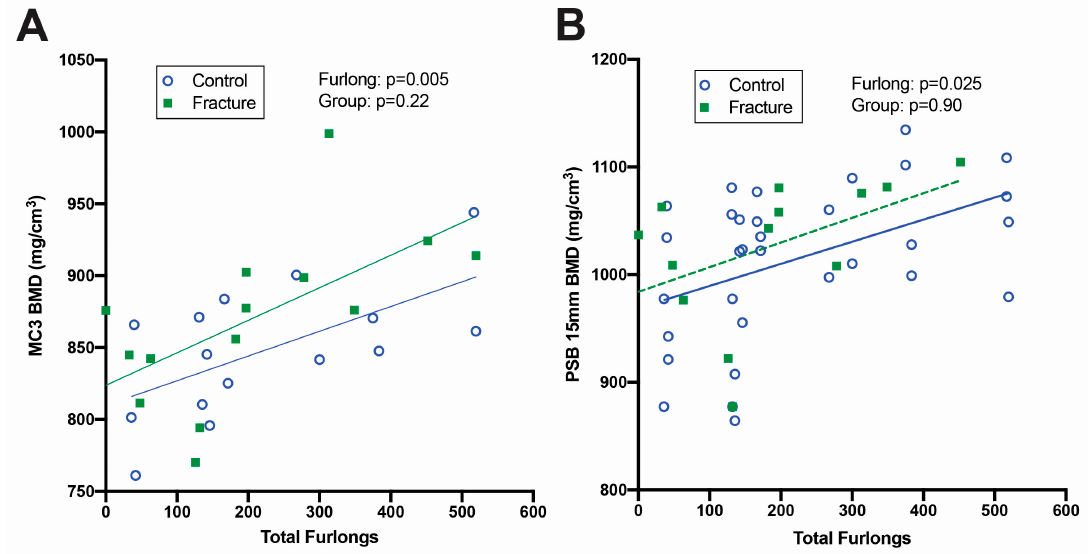
Figure 6. Linear regression analysis of CT images analyzed via radiomics. Bone mineral density (BMD) increased with total furlongs in both the distal third metacarpal bone (MC3) ( A ) and proximal sesamoid bones (PSB) ( B ) but did not differ between fracture cases and controls.